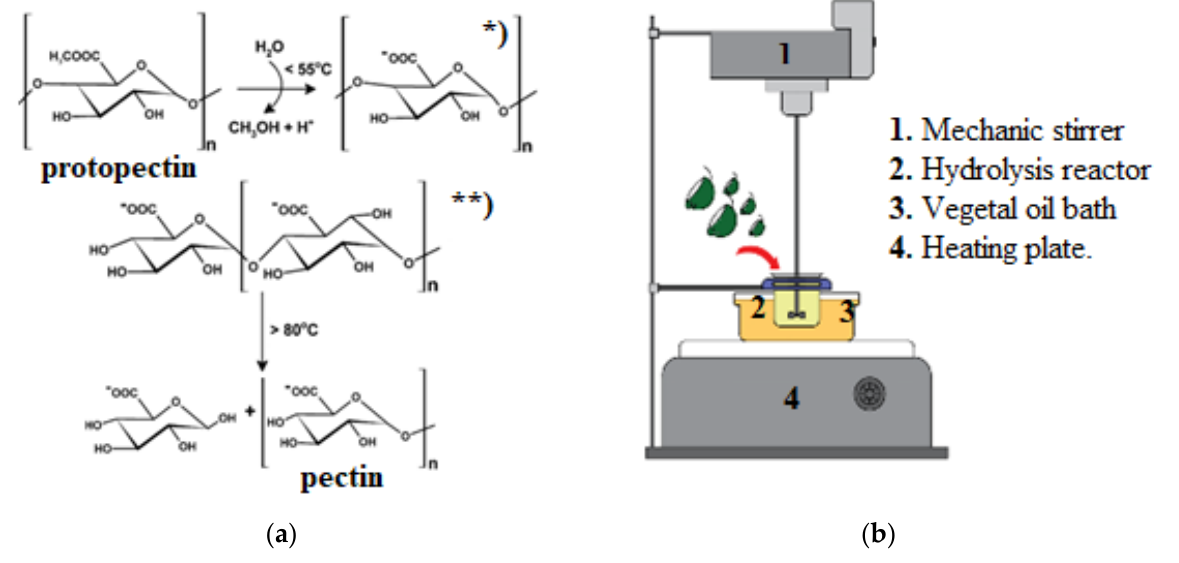
Figure 7. ( a ) Pectin hydrolysis mechanism: * protopectin demethylation, ** protopectin hydrolysis (Lim y Cheong 2015, modified by author); ( b ) pectin extraction system.